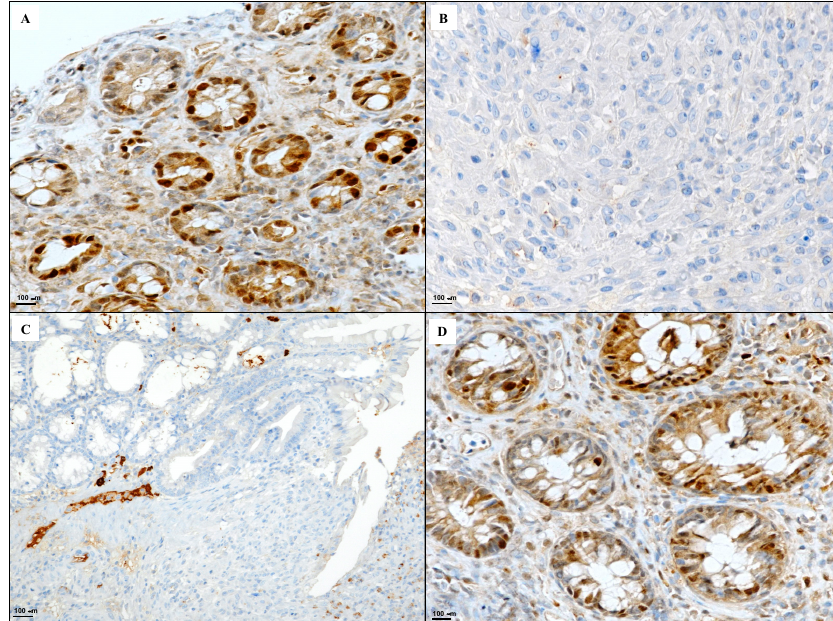
Figure 7. Representative Bcl-2 immunostaining (original magnification ×40) of tissues derived from control ( A ), DNBS + Drug vehicle ( B ), DNBS + Poly ( C ), and DNBS + Poly + HA ( D ).